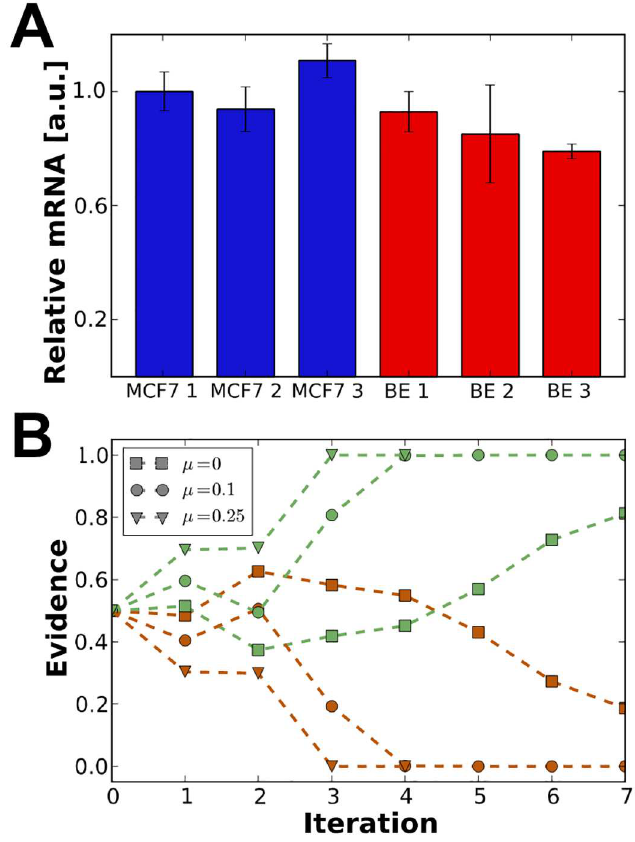
Fig 4. Results of transcriptional analysis and coupled model selection. (A) RelativemRNA levels measuredby quantitative PCR. Bars represent relative mRNA yield, normalised to the first MCF7 sample. Error-bars show one standard deviationderived from the comparative C T measurement. (B) Iterative model selectionresults incorporating qPCR information. Curves representthe evidencesupportingmodel I (in dark orange)and model II (in green) for three weightsof the term penalising differencesin mRNA expressionlevel. Graphs obtained with weight values 0, 0.1 and 0.25 are marked by squares, circles and triangles, respectively, as indicatedin the